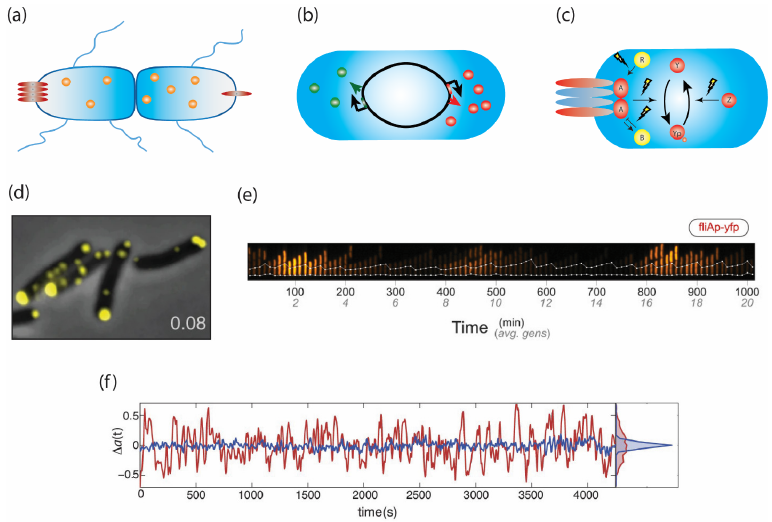
Figure 1. Phenotypic diversity arises from processes operating at different timescales. ( a ) Unequal partitioning of proteins and organelles upon cell division, ( b ) stochastic gene expression, and ( c ) stochasticity in the chemical reactions of signaling pathways all contribute to phenotypic diversity. ( d ) The number and size of chemoreceptor clusters varies from cell to cell due to random partitioning. This variation may lead to diverse sensitivities to stimuli. ( e ) The expression of class II motility genes such as fliA occurs in pulses lasting multiple generations. These pulses are stochastic, likely generating cells with very different sensory and swimming capabilities. ( f ) Fluctuations in the kinase activity of the chemotaxis network. In red are cells containing the adaptation enzymes CheR and CheB, while in blue are cheRB deletants. The cycle of methylation and demethylation, as well as receptor cooperativity both contribute to fluctuations. Panels d, e, and f are adapted from Koler et al., 2018 [34]; Kim et al., 2020 [35]; and Keegstra et al., 2017 [36]. 2.1. Variation Arising at Cell Division One mechanism likely to contribute to long-lasting differences between cells is parti- tioning noise—the unequal distribution of biomolecules between daughter cells during cell division (Figure 1a). General features of partitioning noise and its quantitative treat- ment have been subject to review elsewhere [13,37]. For chemosensing and motility, the partitioning of organelles, such as molecular motors and large receptor clusters, is likely to contribute to phenotypic variability. However, so far, only few studies have examined this aspect of phenotypic variability. Recent studies have determined the location and size distributions of chemoreceptor clusters in growing cells [38,39]. At early growth stages, cells contain multiple small re- ceptor clusters, which are positioned along the length of the cell (Figure 1d) [34]. However, as the culture approaches stationary phase, individual cells typically contain only one or two polar clusters. The resulting cell-to-cell differences in cluster size and number are likely to translate into differences in sensitivity to chemical signals. While a direct link between cluster positioning and portioning noise has not been demonstrated directly, an uneven distribution of chemoreceptor complexes could contribute to long-lasting diver- sity, since some individuals will inherit multiple clusters, while others will inherit none. 2.2. Stochastic Pulses of Motility Gene Expression